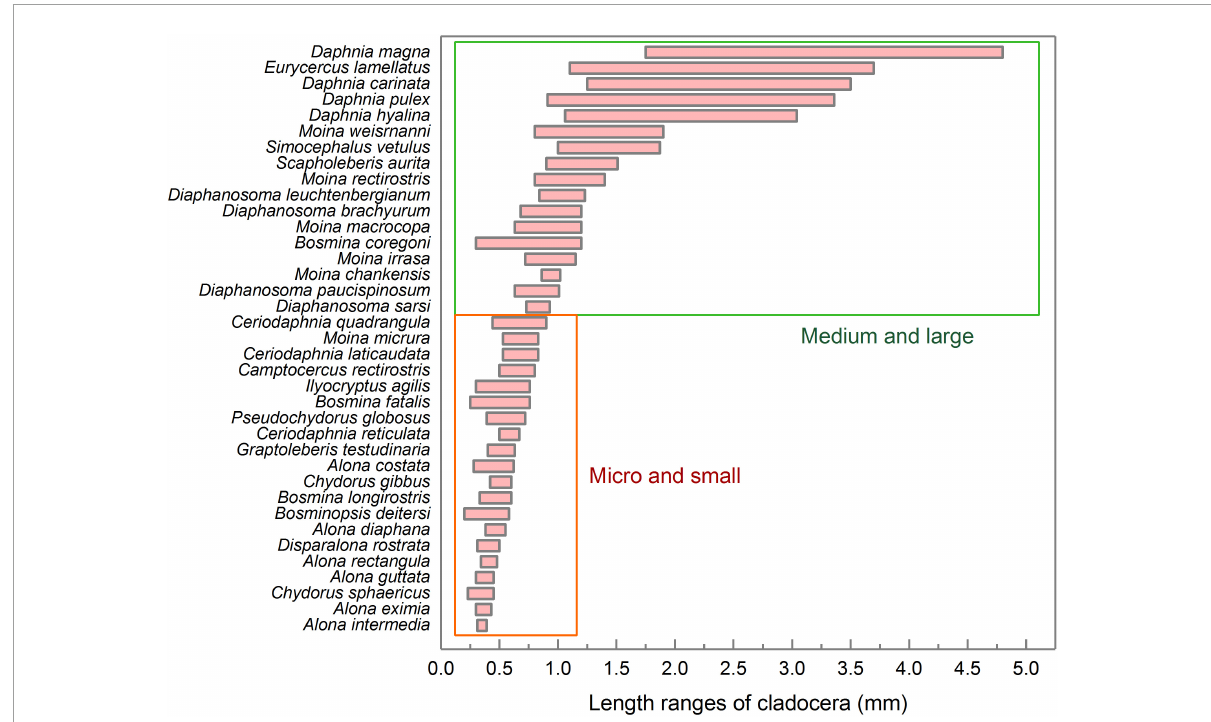
FIGURE5 Length ranges and classification of various cladocera. The statistics for the body length range included both female and male individuals. The data for the cladocera body lengths come from the China Animal Scientific Database (http://www.zoology.csdb.cn/), which was